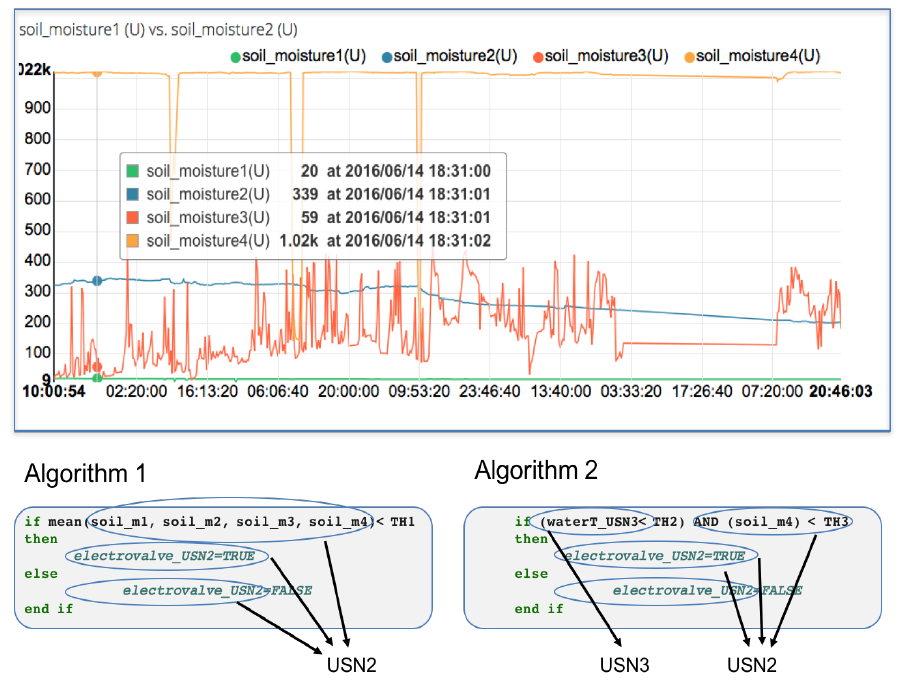
Figure 11. Cloud server graphic of soil moisture sensors data and control algorithms designed by